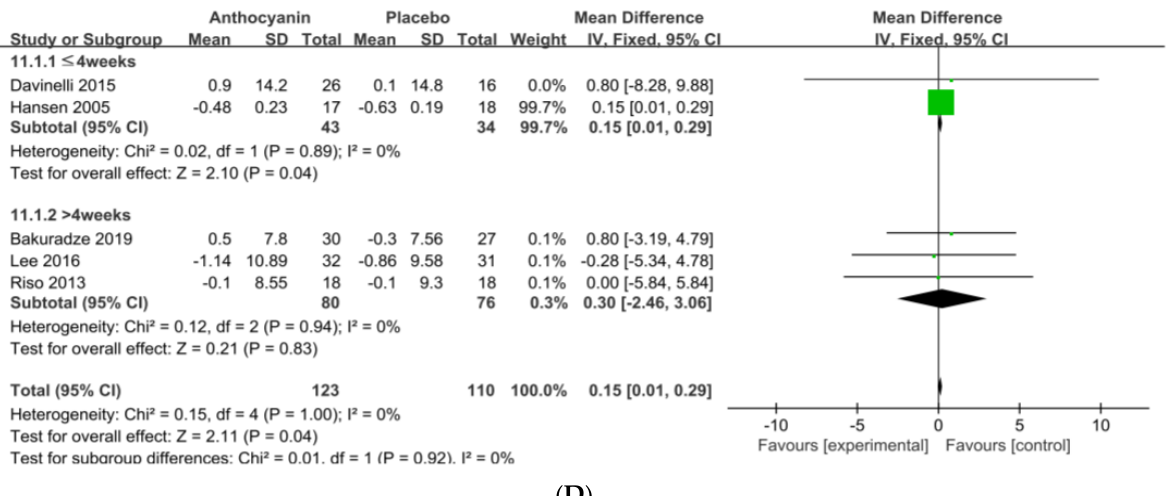
Figure 4. Forest plot of BW changes ( A ) and the subgroup analysis of obesity degree ( B ), treated levels ( C ), and intervention periods ( D ). Abbreviations: SD: standard deviation, CI: confidence interval, df:degrees of freedom, Statistical heterogeneity was assessed by I 2 test, Chochran's Q-test; I 2 : Higgin's I 2 test, Chi 2 : Cochran’s Q-test, IV: inverse variance, Z: Z-score, P: P-value.